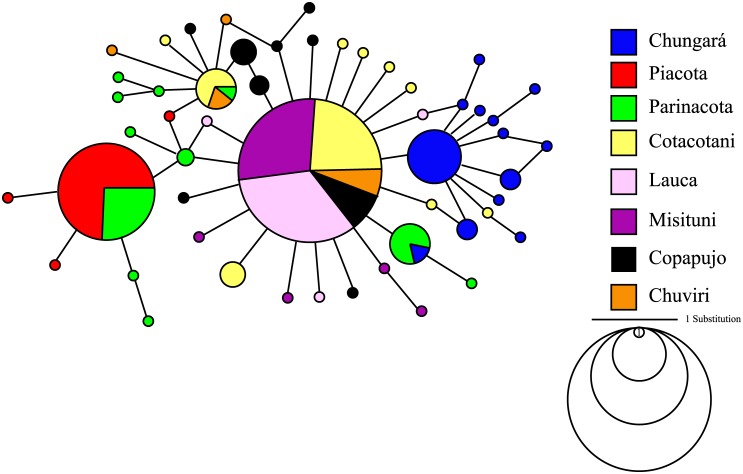
Median joining network of mitochondrial control region haplotypes including 270 mtDNA d-loop control region sequences in the 8 sampling sites.Each haplotype is represented by a colored circle indicating the main site where it was collected; the size of the circle is proportional to its frequency in the whole sampling effort.